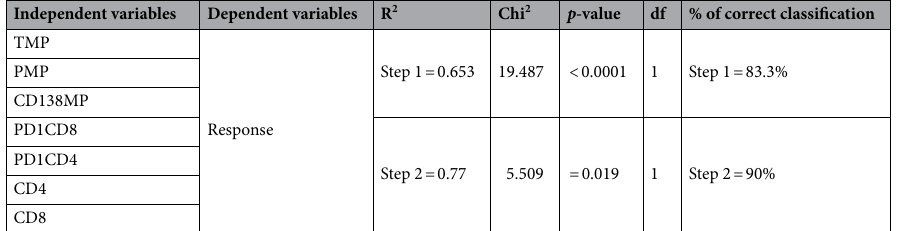
Independent variables